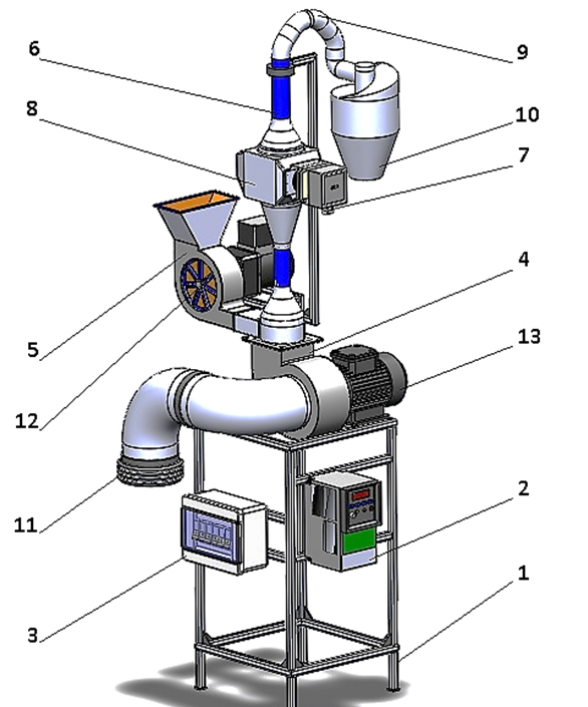
Figure 1. General view of the drying plant in suspended layer: 1 -